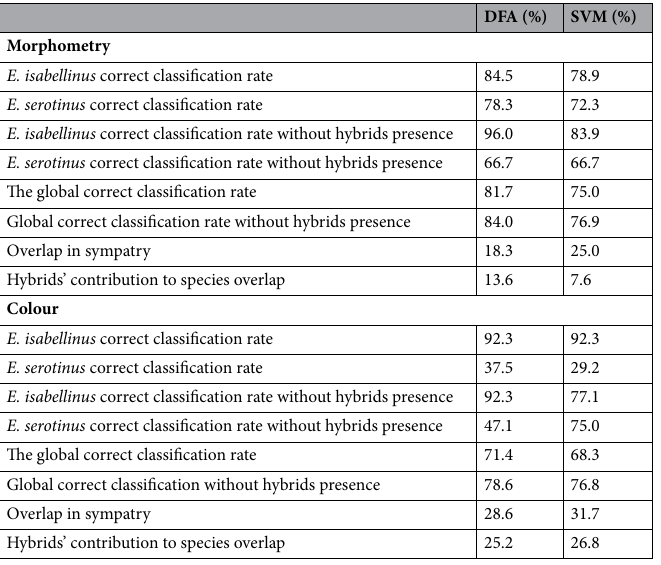
Table 3. Correct species classification rates, species overlap and hybrids’ contribution to species overlap that were obtained by two different methods of classification statistics (DFA and SVM) based on morphometric and colour traits of E. isabellinus and E. serotinus in